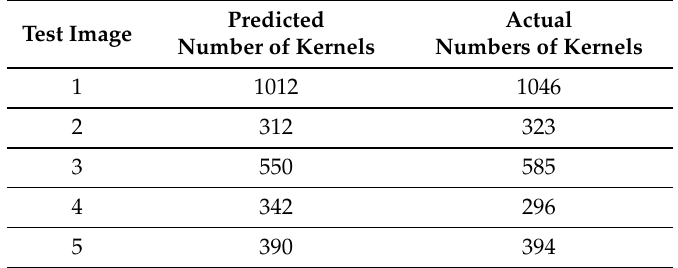
Table 4. The predicted and the ground truth numbers of the kernels on test images shown in Figure 8.